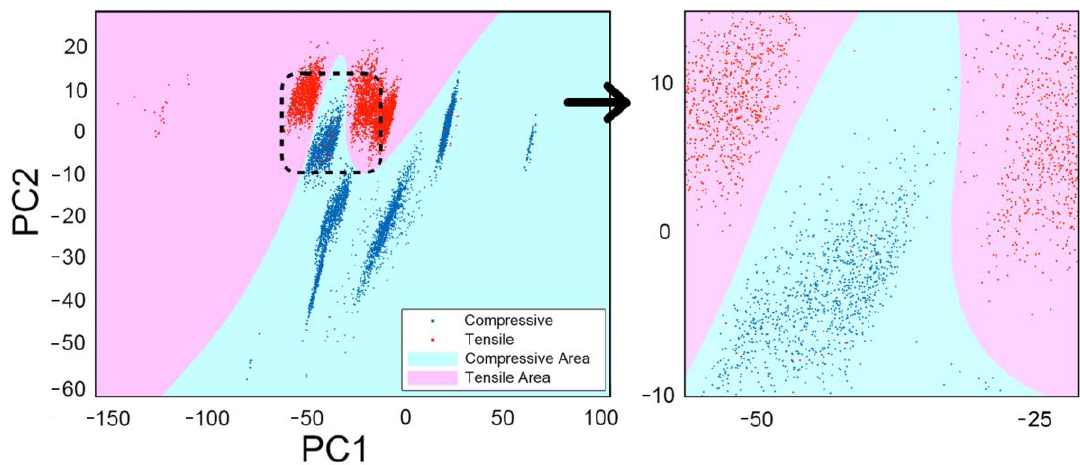
Figure 9. Performed model using a [9-6-3] MLP with PC1 and PC2 input, and successfully classified the stress as compressive or tensile.